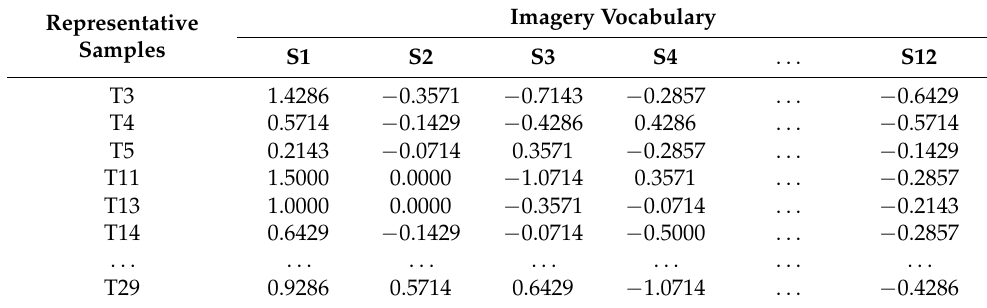
Table 2. Semantic evaluation mean values.